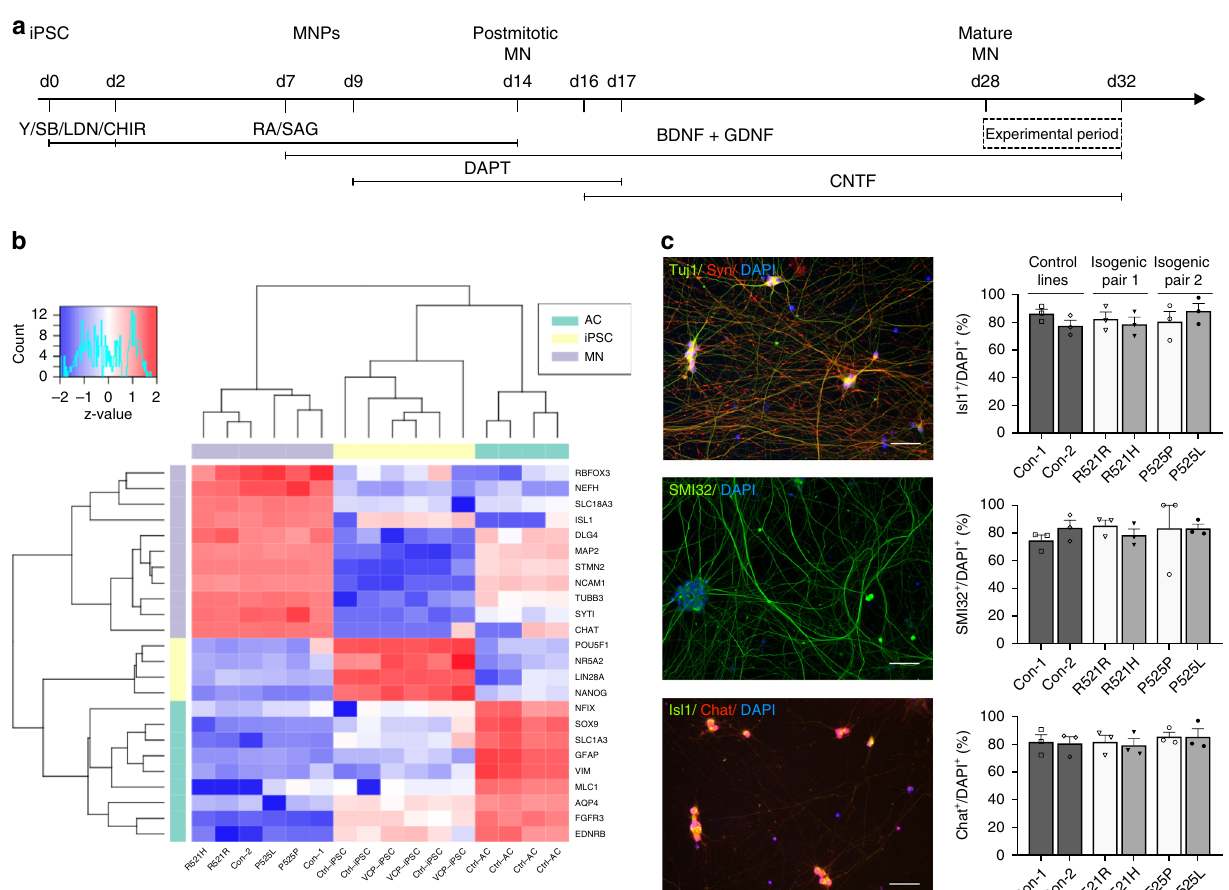
Fig. 1 Characterisation of iPSC-derived MNs from ALS patients and controls. a Schematic overview of motor neuron differentiation from iPSCs with indication of timing when motor neuron experiments were performed. b Bulk RNA-sequencing analysis indicating enrichment of motor neuron-speci fi c transcripts in human iPSC-derived motor neurons versus iPSCs and astrocytes. Raw data are deposited publicly, EGA (EGAS00001003785). c Representative staining of pan-neuronal markers (Tuj1 and Synapsin1) and staining and quanti fi cation of motor neuron markers (Isl1, ChAT and SMI-32) in motor neurons from controls (black bars; Con-1, Con-2), FUS-patients (dark grey bars; R521H, P525L) or isogenic controls from these patients (light grey bars; R521R, P525P). Scale bar, 50 μ m. Motor neurons were between 28 and 32 days old for all experiments. Statistical analyses in panel c was performed by one-way ANOVA with post hoc two-tailed t tests between cell lines. In c , data are presented as mean ± s.e.m. from three individual experiments, with the individual data points shown. Source data are provided as a source data fi le. iPSC induced pluripotent stem cell, MNPs motor neuron progenitors, MN motor neuron, Y Y-27632, SB SB 431542, LDN LDN-193189, CHIR CHIR99021, RA retinoic acid, SAG smoothened agonist, DAPT a γ -secretase inhibitor, BDNF brain-derived neurotrophic factor, GDNF glial cell-derived neurotrophic factor, CNTF ciliary neurotrophic factor, AC astrocyte, Con-1 control cell line 1, Con-2 control cell line 2, R521H cell line derived from a patient carrying the R521H mutation in FUS, R521R CRISPR-Cas9-corrected R521H, P525L cell